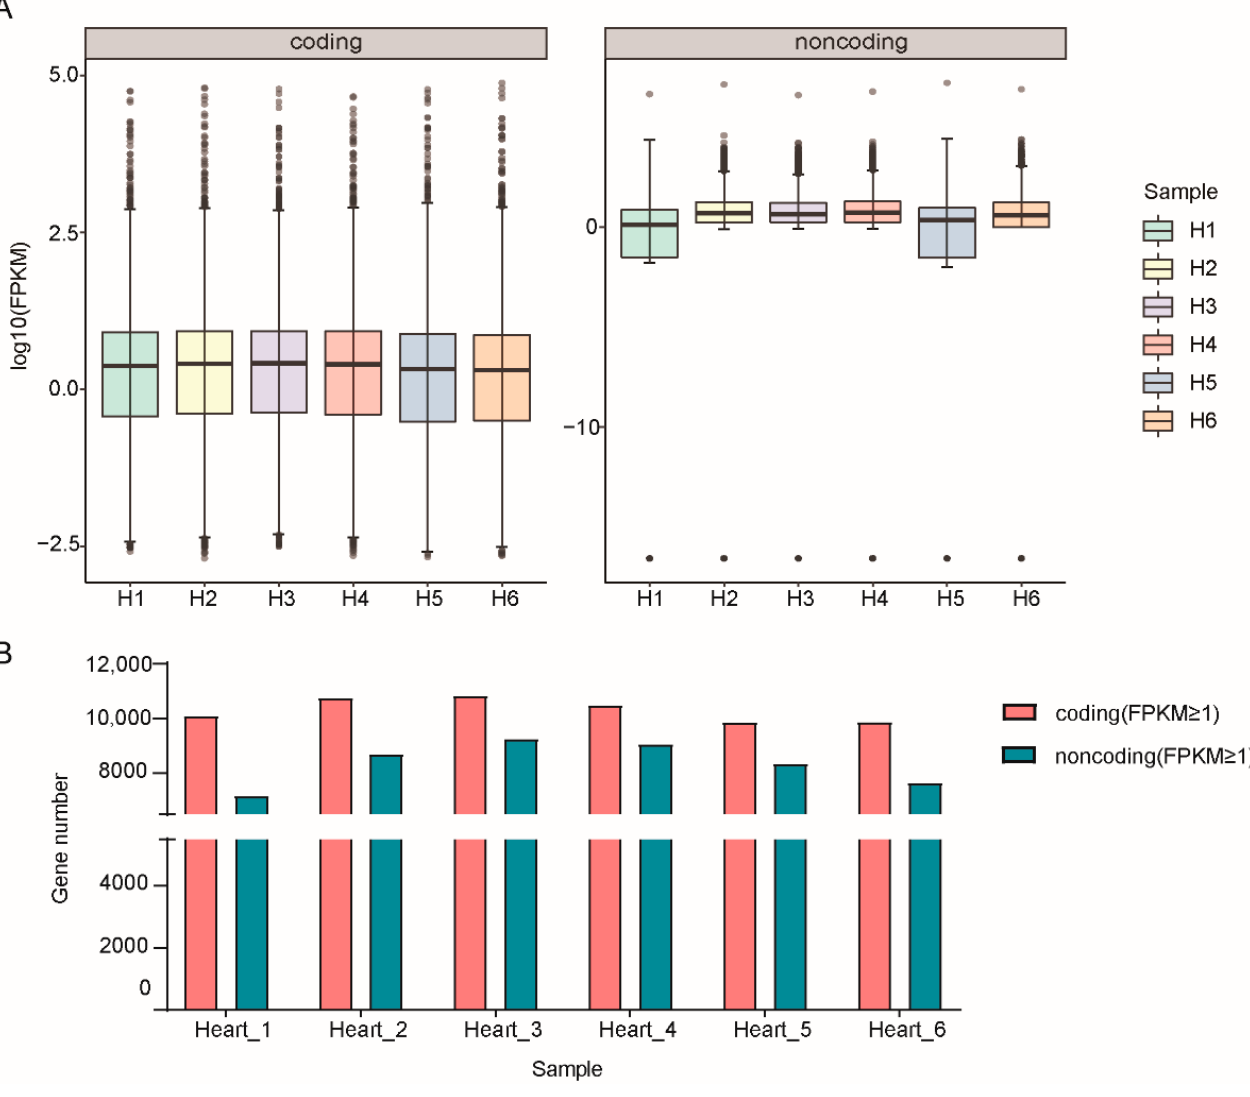
Figure 1. Statistics of all expressed genes identified from RNA-seq data in this study. ( A ) Expression levels of mRNAs and lncRNAs. ( B ) Gene numbers of mRNAs and lncRNAs with each sample. Principal component analysis of all genes and lncRNAs was conducted using the R language package. Figure 2A shows that the mRNAs expressed in the three samples of WT and the samples of the ZBED6 -KO group were clustered together, with PC1 accounting for 62.18%, indicating that the repeatability of each group was good. Similarly, the PCA of lncRNAs showed the same result, which significantly separated the two groups, with PC1 accounting for 100% (Figure 3B). Although individual “Heart 4” deviated in the group, the cluster analysis of the differential genes indicated that the data were accurate and dependable and could satisfy the subsequent difference